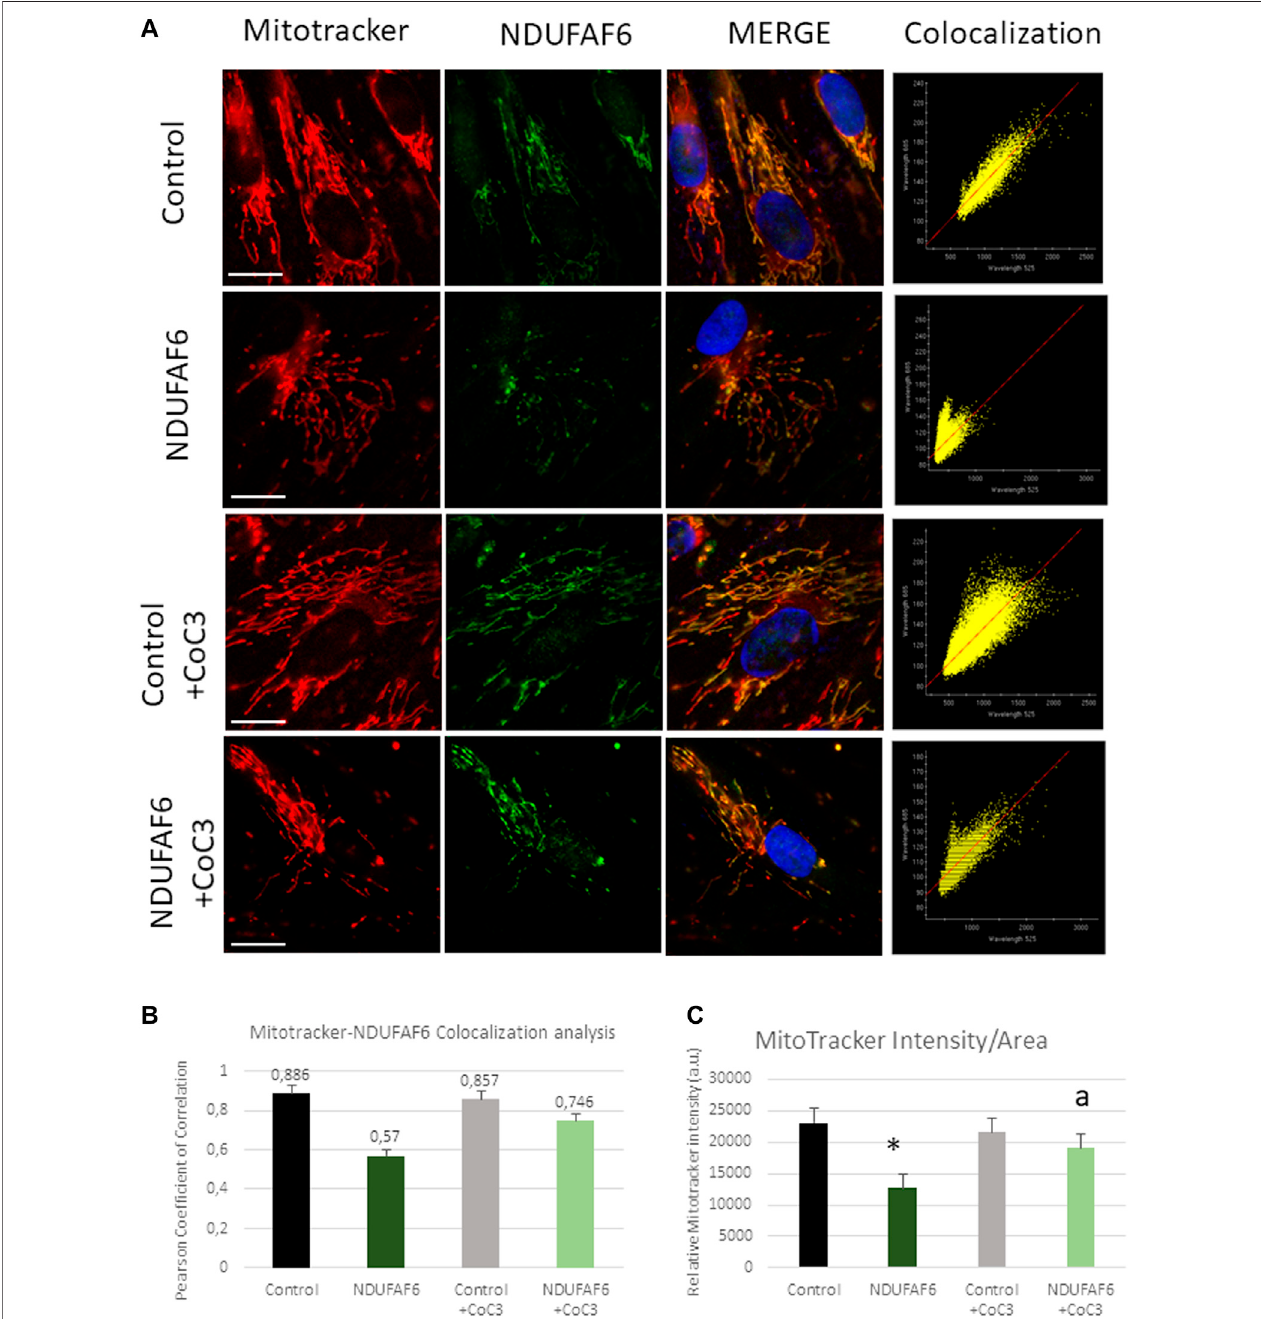
FIGURE 3 | Effect of CoC3 on NDUFAF6 protein expression levels and mitochondrial network in control and mutant NDUFAF6 fi broblasts. Control and mutant NDUFAF6 fi broblasts were incubated with Mitotracker DeepRed FM 100 nM for 45 min, then they were fi xed and immunostained with anti-NDUFAF6 (NADH: Ubiquinone oxidoreductase Complex Assembly Factor 6) and examined by fl uorescence microscopy. Nuclei were revealed by 1 μ g/ml Hoechst staining (A) . Colocalization analyses (B) and MitoTracker (C) intensity assessment were performed using softWoRx and ImageJ softwares. CoC3 treatment: 1 μ M Pterostilbene, 5 μ M nicotinamide, 1 μ M ribo fl avin, 1 μ M thiamine, 1 μ M biotin, 5 μ M lipoic acid and 1 μ M L -carnitine. * p < 0.05 between control and mutant NDUFAF6 cells; a p < 0.05 between non-treated mutant NDUFAF6 and treated mutant NDUFAF6 cells. Scale bar = 15 μ m.